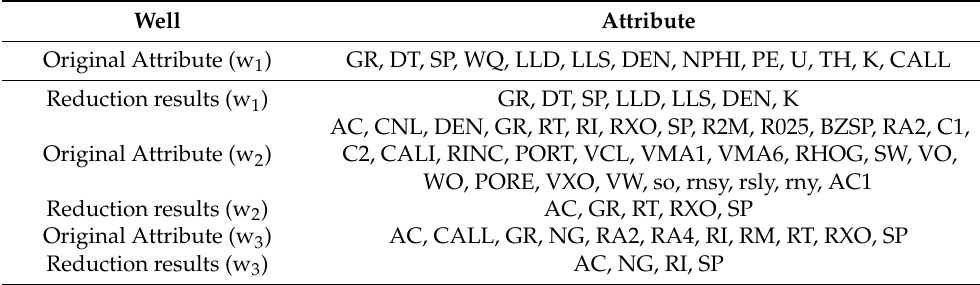
Table 1. Reduction results of logging data.